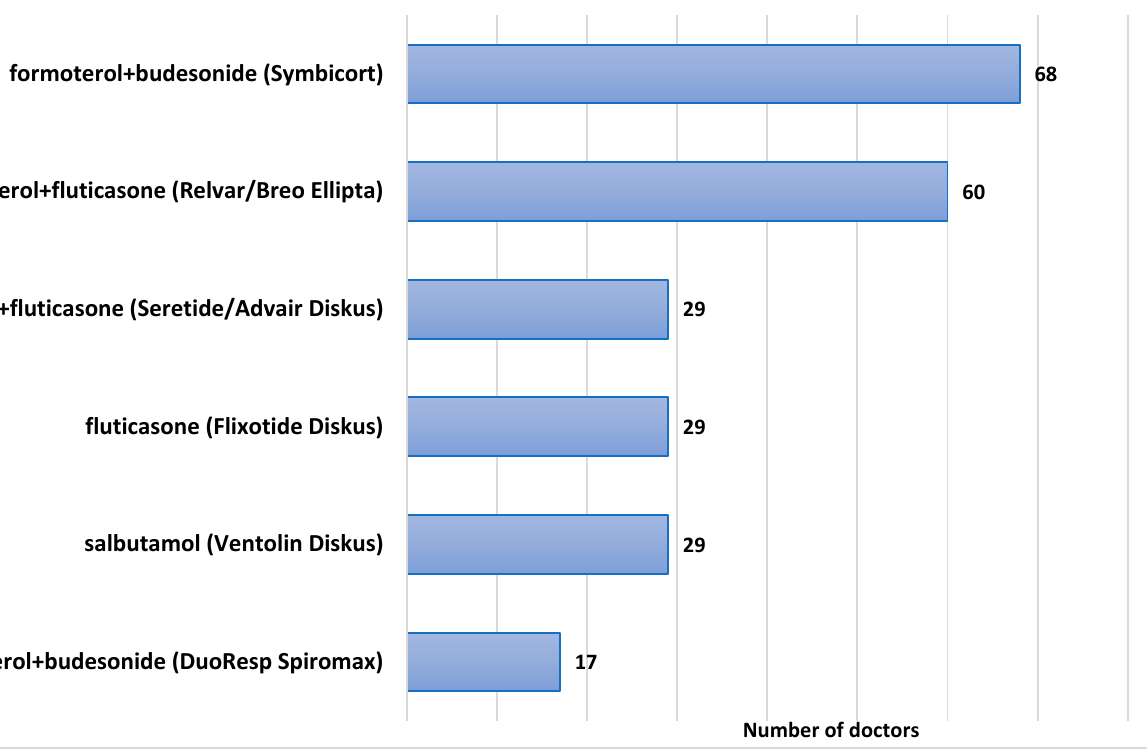
Figure 1. Frequently prescribed Dry-Powder Inhalers for asthma.